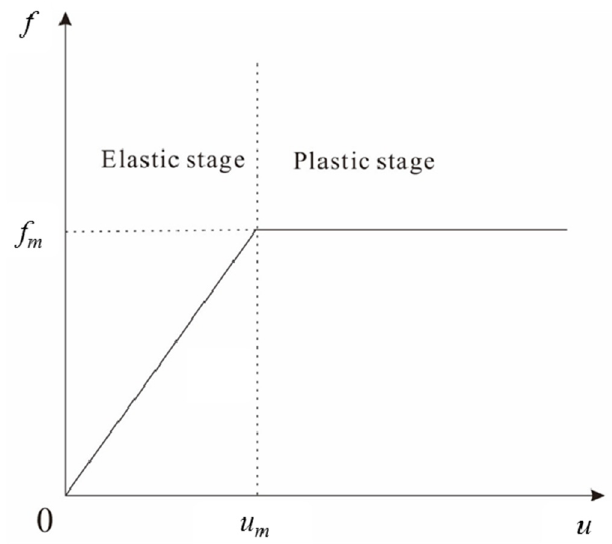
Figure 2. The ideal elastoplastic relationship between skin friction of the pile and the relative settlement of pile soil.